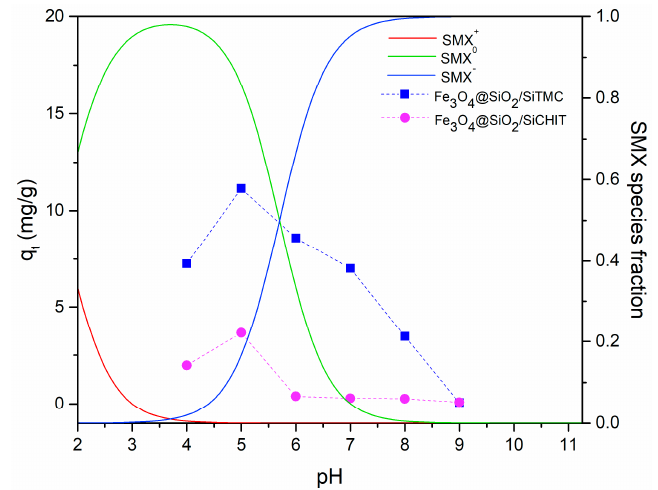
Figure 6. Effect of pH of the medium on the removal of sulfamethoxazole from water, for an initial SMX concentration of 40 mg/L and 24 h contact time and speciation of SMX [68].